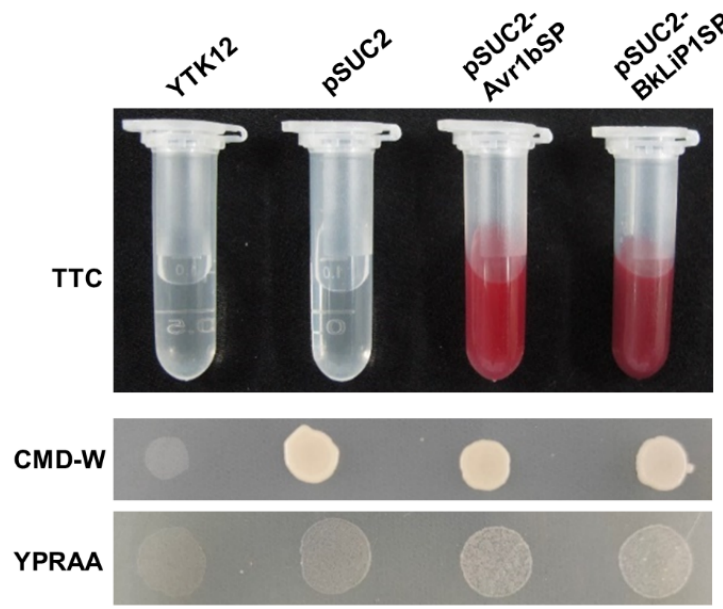
Figure 3. Secretion activity analysis of BkLiP1 in B. kuwatsukai . Invertase activity analysis in TTC medium and yeast growth on CMD-W or YPRAA plates. The yeast SUC2 mutant YTK12 and its transformants express the empty vector pSUC2 or vectors with the signal peptide from BkLiP1 and Avr1 (positive control).